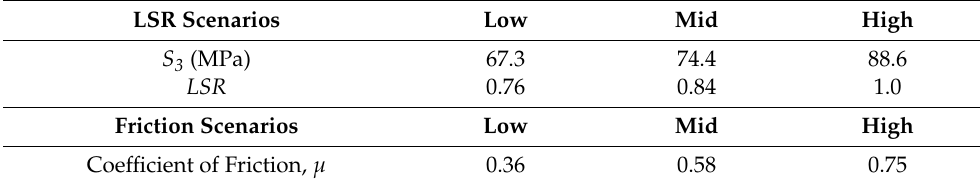
Table 2. Scenarios for LSR and fault friction angle sensitivities.